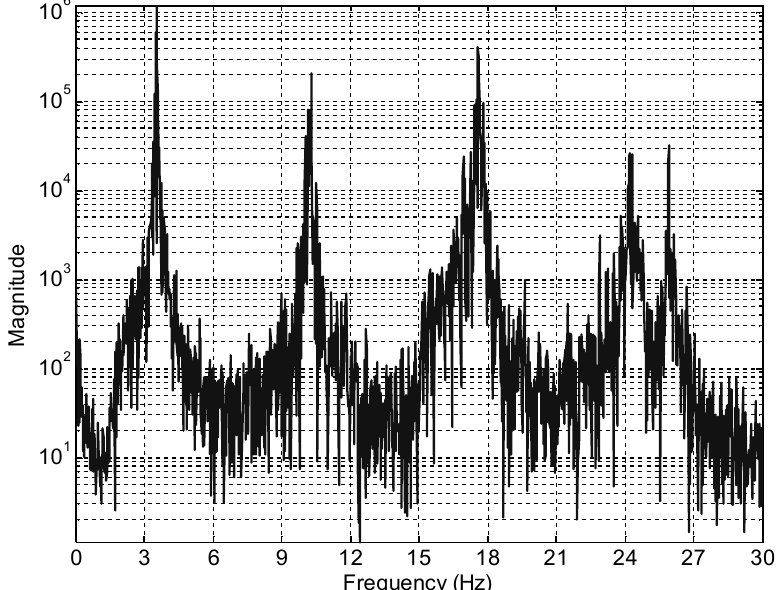
Fig. 9. Dominant singular value for output PSD, DC1 (FDD).